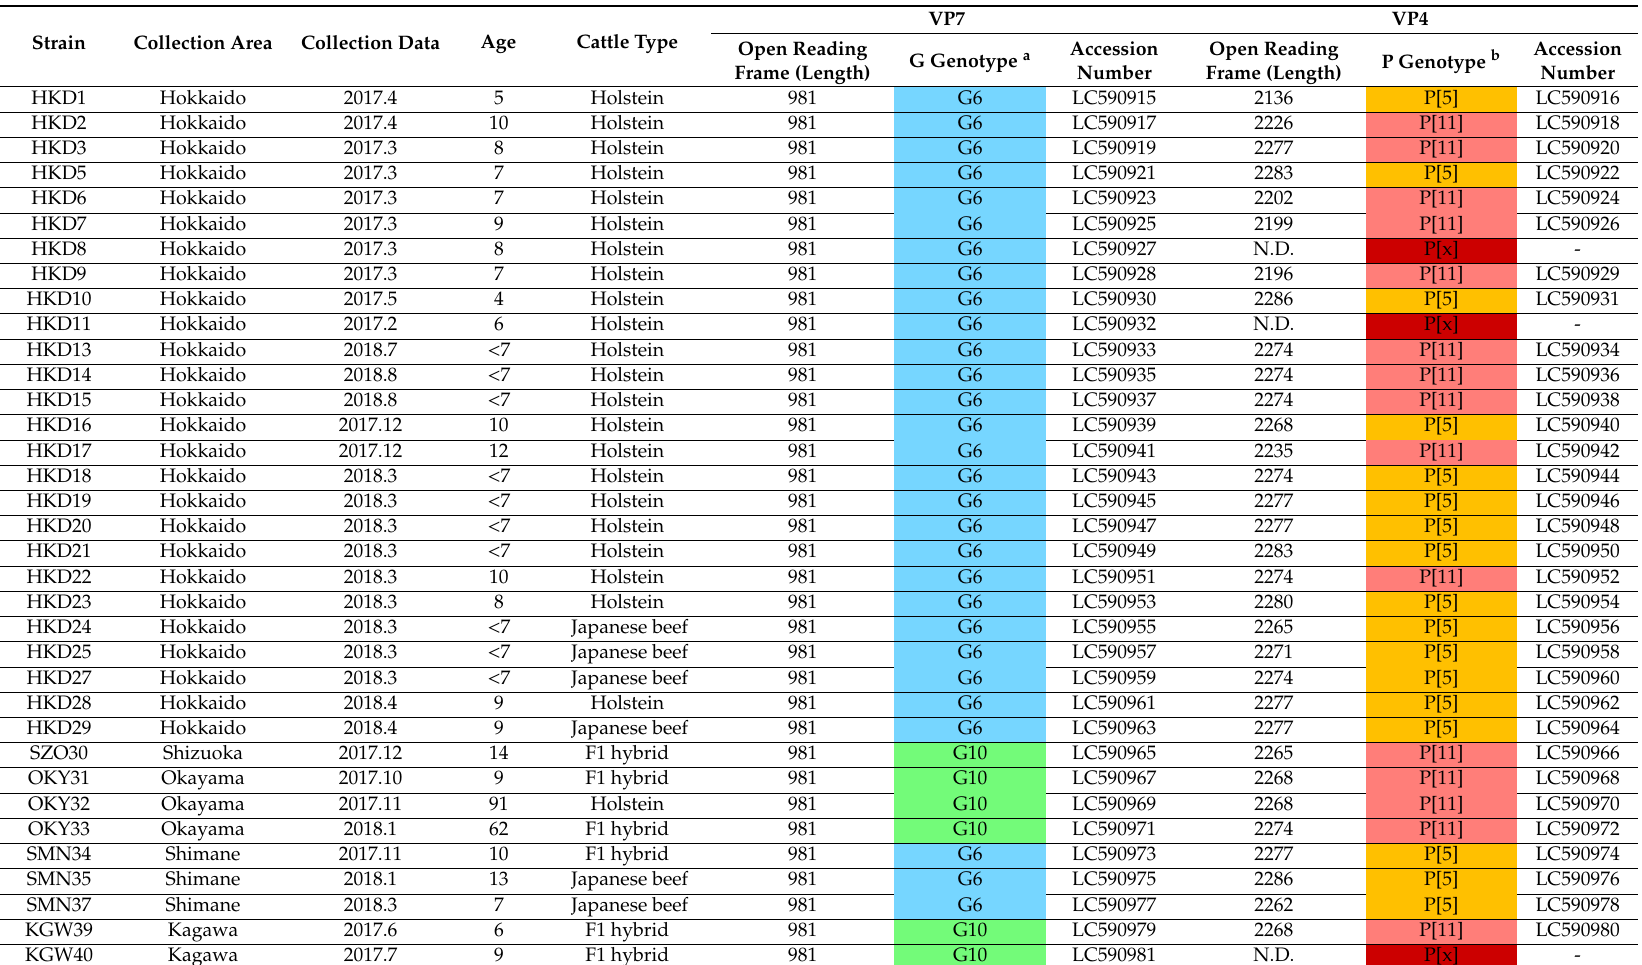
Table 1. Summary of individual information, and VP7 (G) and VP4 (P) genotypes of 99 bovine rotavirus A strains collected in Japan from 2017 to